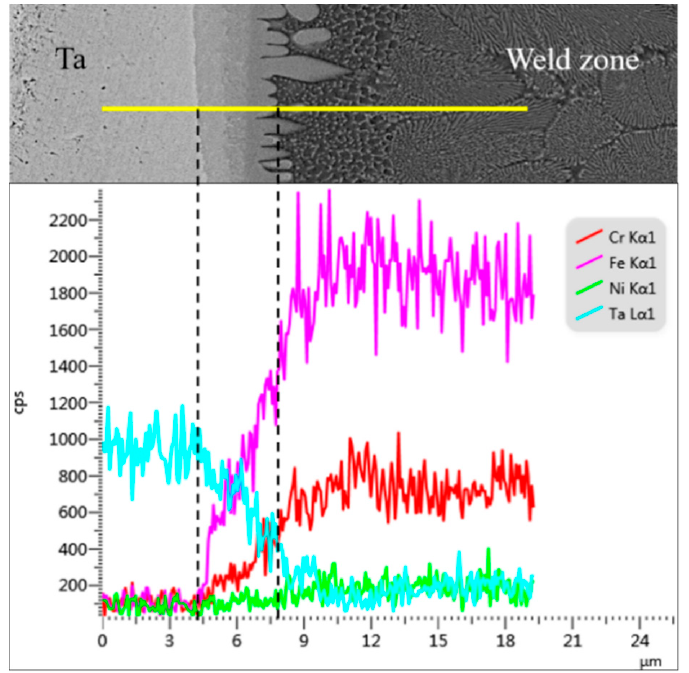
Figure 9. EDS line scan results at bottom of weld.